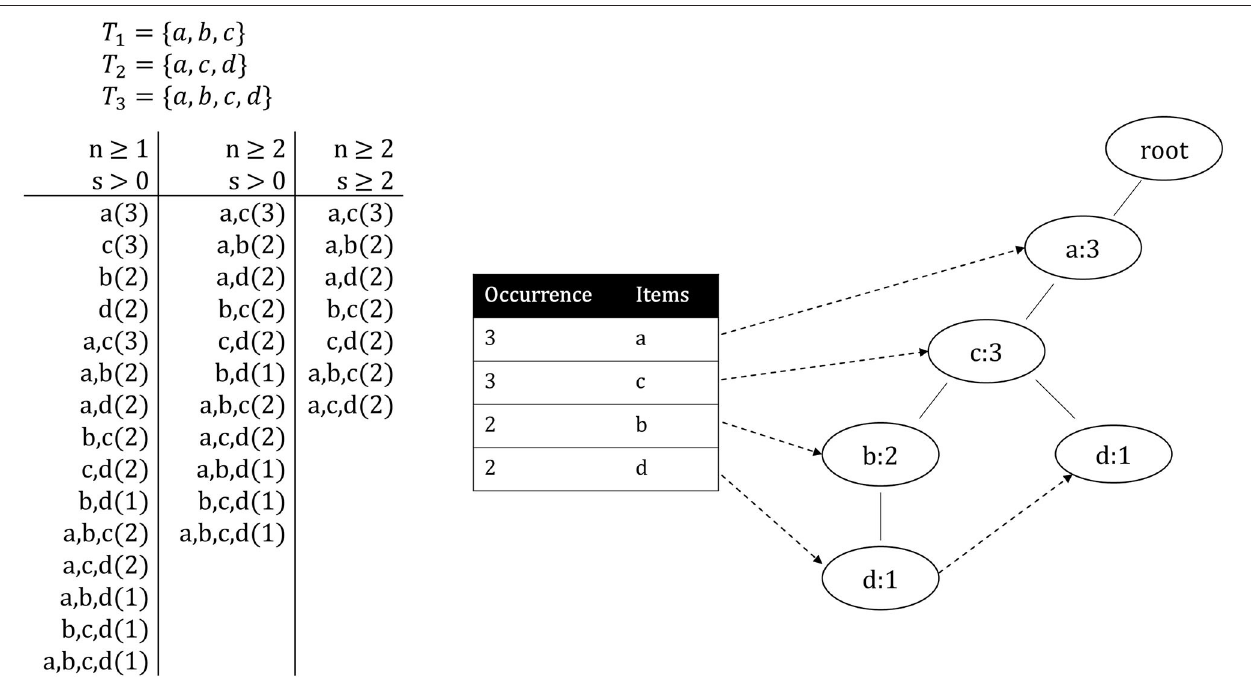
FIGURE 1 | Left : All patterns from the pattern mining example presented in section 2.1. Right : The header table and FP-tree created from the same example transactions.